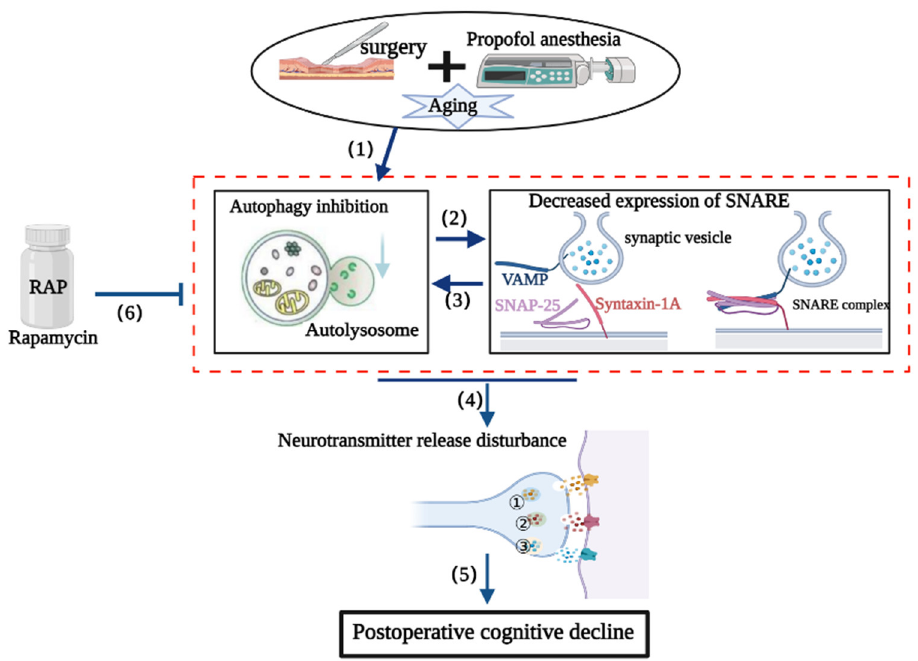
Figure 8. Possible mechanism of SNARE complex disturbances in the delayed neurocognitive re- covery (dNCR) pathological process. (1) Surgery can inhibit autophagy in the hippocampus. (2) Hippocampal autophagy inhibition further exacerbates the structure and function of the SNARE complex. (3) SNARE complex dysfunction further aggravates the impairment of autophagy. (4) SNARE complex disturbances and disrupted hippocampal autophagy impair neurotransmitter re- lease, ultimately promoting delayed neurocognitive dysfunction (5). (6) Rapamycin can ameliorate postoperative neurocognitive deficits, probably by restoring suppressed autophagy and then im- proving the structure and function of the SNARE complex. ① norepinephrine; ② dopamine; ③ 5- hydroxytryptamine. There were several limitations to the current study. First, the experiment did not rep- resent a clinical setting and the inhalation anesthetics sevoflurane and isoflurane have sedative as well as analgesic and muscle-relaxant effects [50]. However, the intravenous anesthetic propofol only has a sedative effect [51]. Therefore, it was not appropriate that we used propofol alone to perform an extremely invasive surgery in rats without an an- algesic before and during surgery. Although oxybuprocaine hydrochloride gel was ap- plied topically after surgery every 8 h for 48 h, this may have been inadequate. The loss of consciousness does not prevent the transmission of pain stimuli and processing by the central nervous system [52]. Moreover, the SNARE complex is also involved in the noci- ceptive pathway [53–55] and this will have definitely affected our results. Second, this study cannot fully explain the effect of propofol on postoperative cognitive function be- cause no alternative injectable anesthetics were used for the sham group. Moreover, SNARE proteins are targets of general anesthetics, including propofol [56–59]. Third, we used laparotomy to generate the dNCR model. Accumulating evidence supports the gut–brain axis as being extremely important for maintaining the function of the central nervous system (CNS) and intestinal dysbiosis can affect cognitive function during multiple chronic CNS diseases [60]. Although we did not explore the intestinal environment, our previous study indicated that the intestinal microbiota can affect cogni- tive function by affecting the activation of central microglia in APP/PS1 mice [61]. There- fore, a new research direction may be to explore the mechanism by which the intestinal environment affects the synaptic vesicle function of neurons. Fourth, open-field fear con- ditioning and radial arm maze tests may be more suitable for animals 24 h post-surgery compared with the Morris water maze test, which requires animals to be put into water.